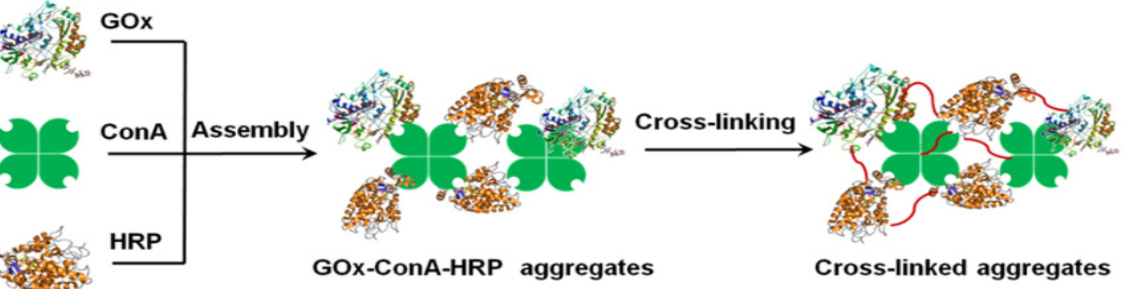
Figure 2. Illustration combi-CLEAs preparation using glucose oxidase, GOx, horseradish peroxidase HRP, ConA as glue protein and glutaraldehyde as crosslinker [77]. Reprinted with permission from [77]. Copyright (2016) America Chemical Society .